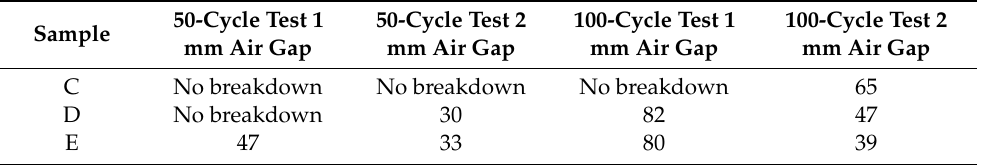
Table 2. Number of cycles of sample